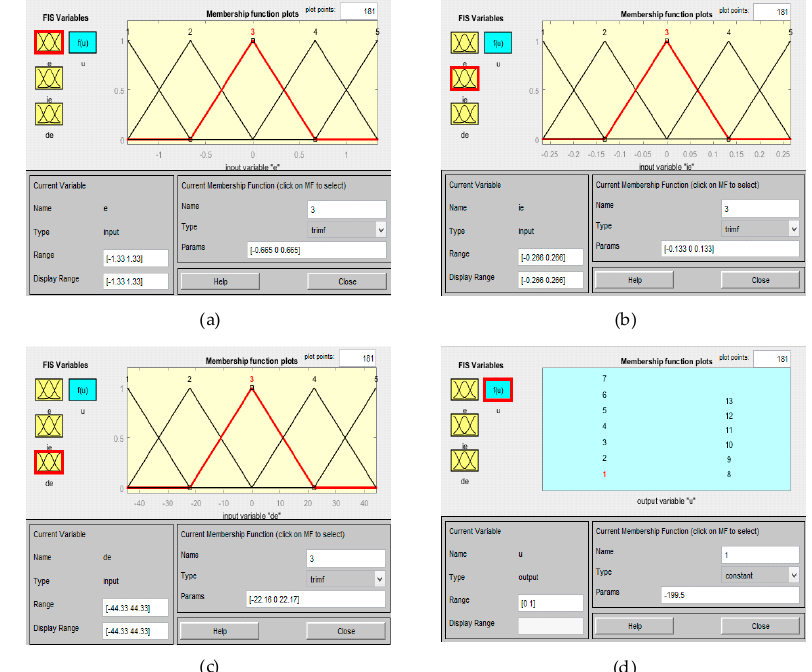
(cid:82) . e ( t ) ; ( c ) e ( t ) ; and ( d ) u ( t ) in Matlab.